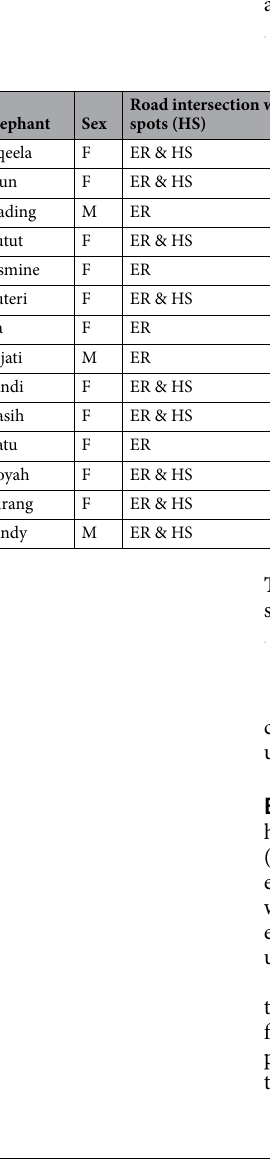
Road intersection with entire range (ER) and hot Elephant Sex spots (HS)